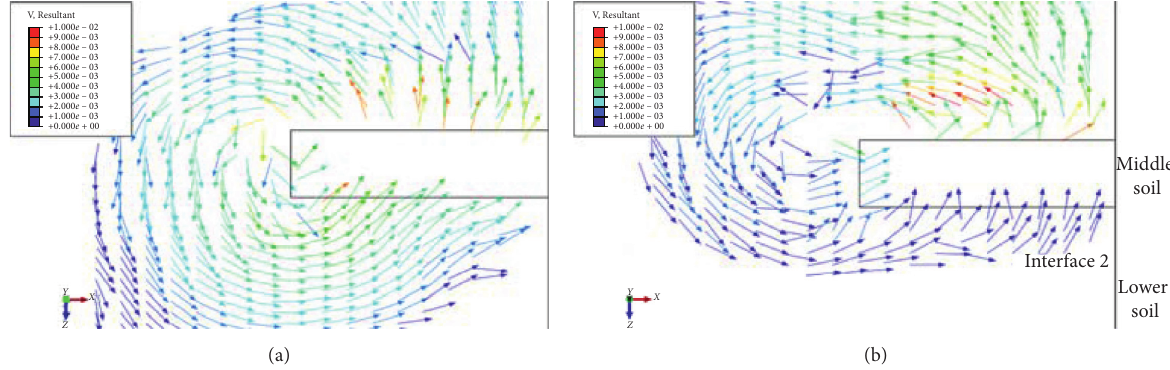
Figure 5: Soil flow under different formation conditions ( H � 10m). (a) Single-layer soil. (b) Layered soils.